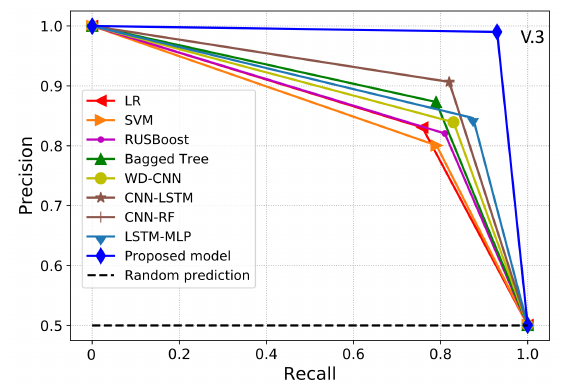
Figure 9. PR-AUC-based performance comparison with existing